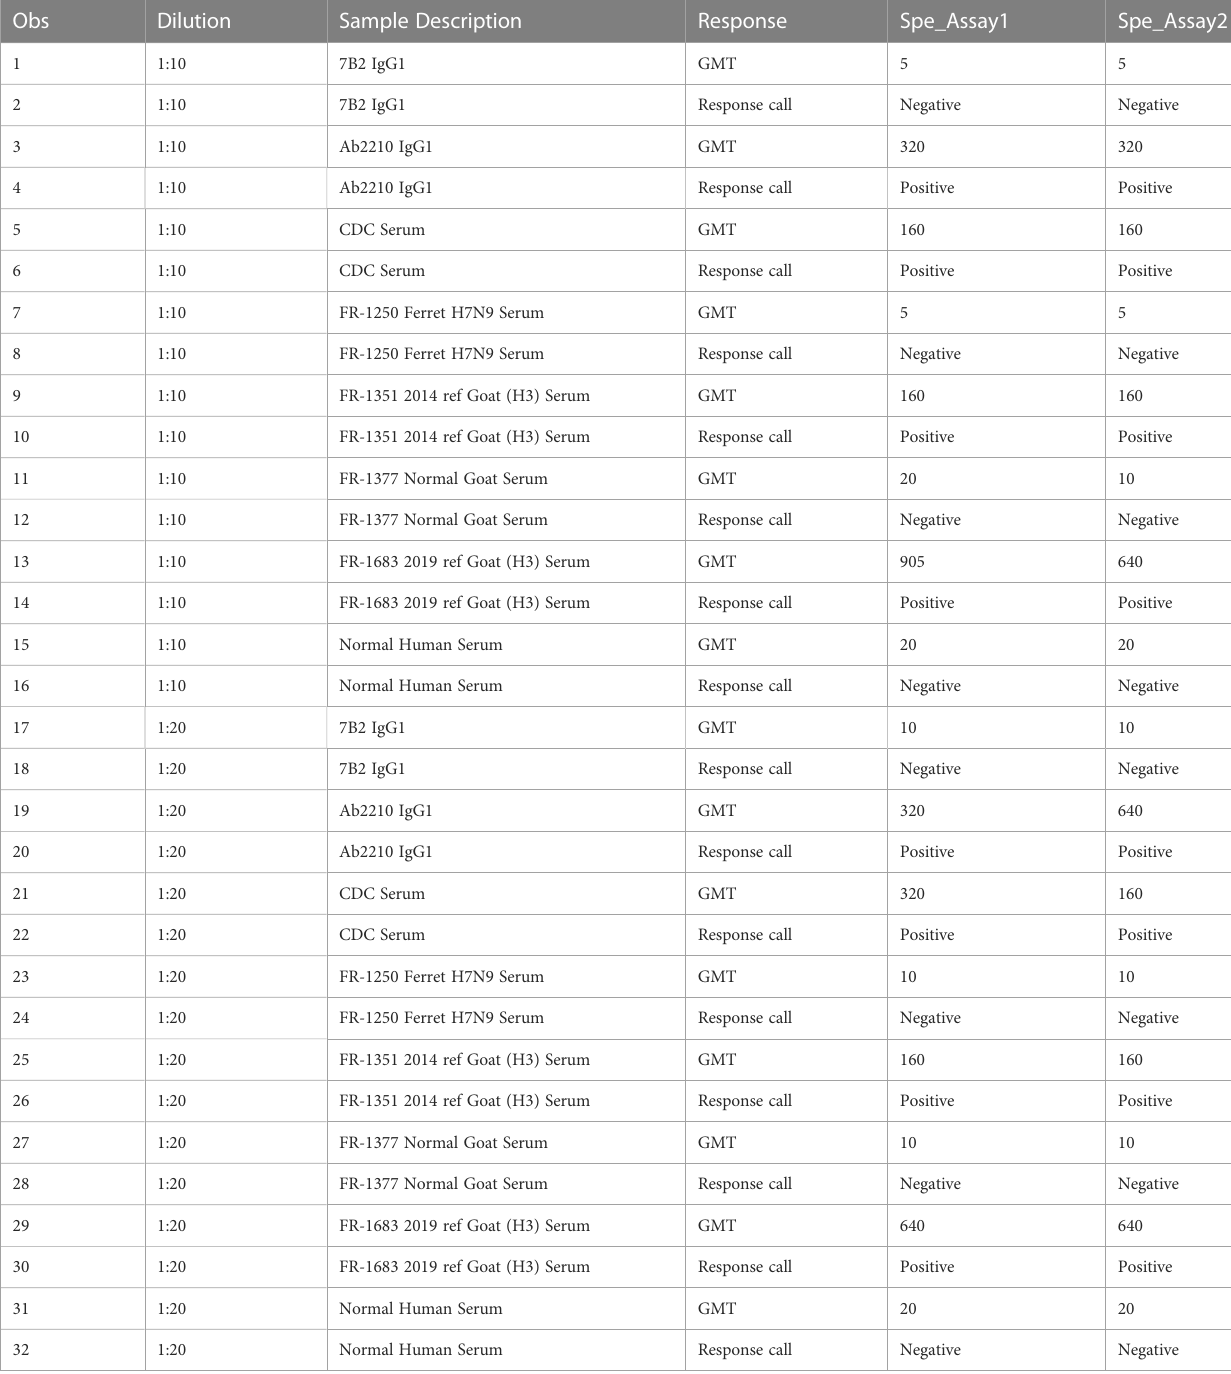
TABLE 8 HAI assay quali fi cation on H3N2 in fl uenza strain A/Texas/71/2017, speci fi city testing, and response calls. Obs